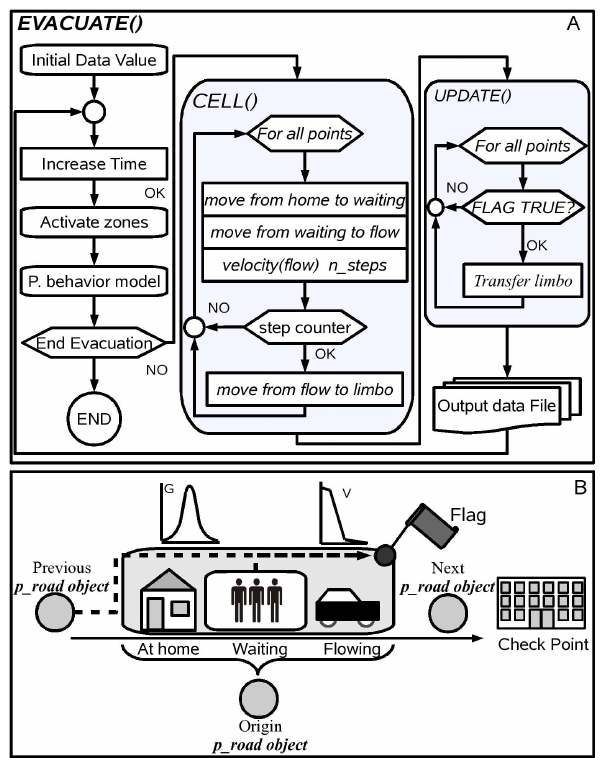
Fig. 10. Example of VSEM output files. (A) Output data that may be represented as plots. A1 is a data compiled plot and represents all output parameters obtained for the evacuation area. A2 is waiting status by zones. All output parameters can be plotted by zones or by working area. (B) Graphical output of VSEM. In these three figures the traffic delay evolution is represented (see text for more details). (C) GIS text output file. This file can be imported directly into the